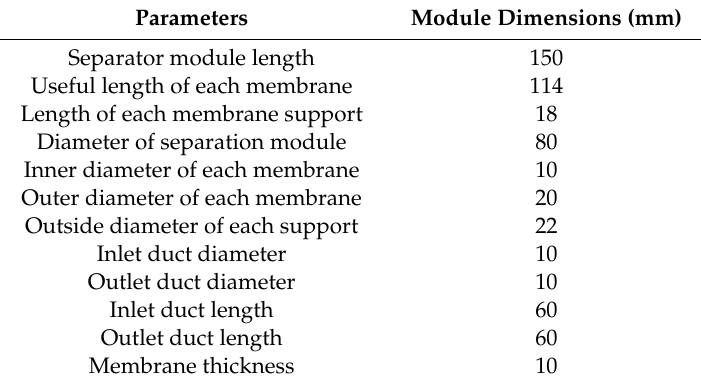
Table 1. Geometric dimensions of the shell-tube separation